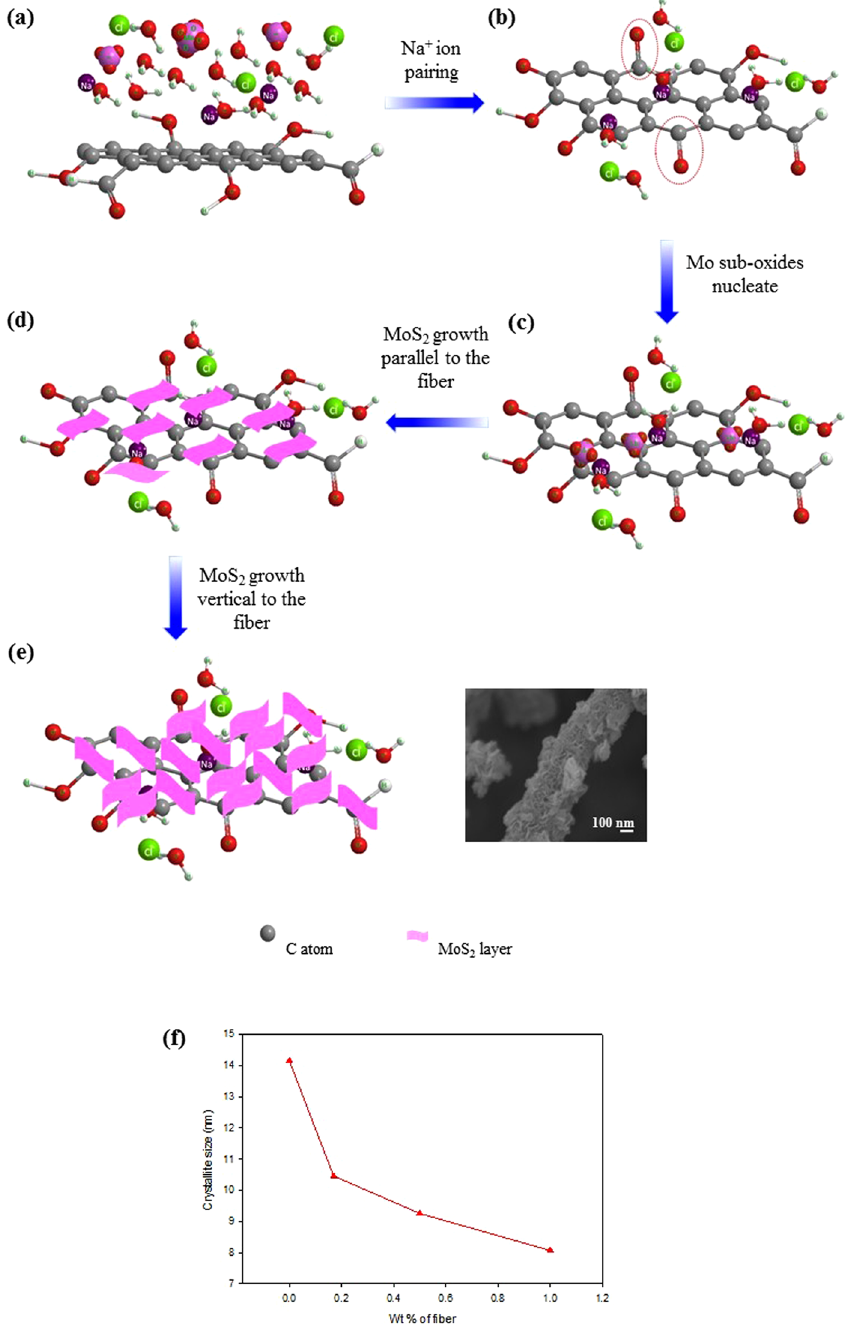
Figure 6. Schematic illustration growth mechanism of MoS 2 nanowall on VGCNF assisted by NaCl. ( a ) Fiber in the solution containing solvated Na + and Cl − , MoO 3 , and Mo 4 O 11 , ( b ) Na + ion pairing to the fiber and additional carbonyl group (C = O) indicated by red circle dash line, ( c ) MoO 3 and Mo 4 O 11 start to attract and nucleate on the fiber surface, ( d ) MoS 2 layer growth parallel to fiber surface, ( e ) MoS 2 layer tend to curveting and growth vertical to the fiber and its SEM image, and ( f ) crystal size decreasing with increasing of fibers